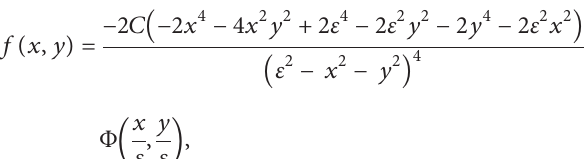
Figure 10: The δ